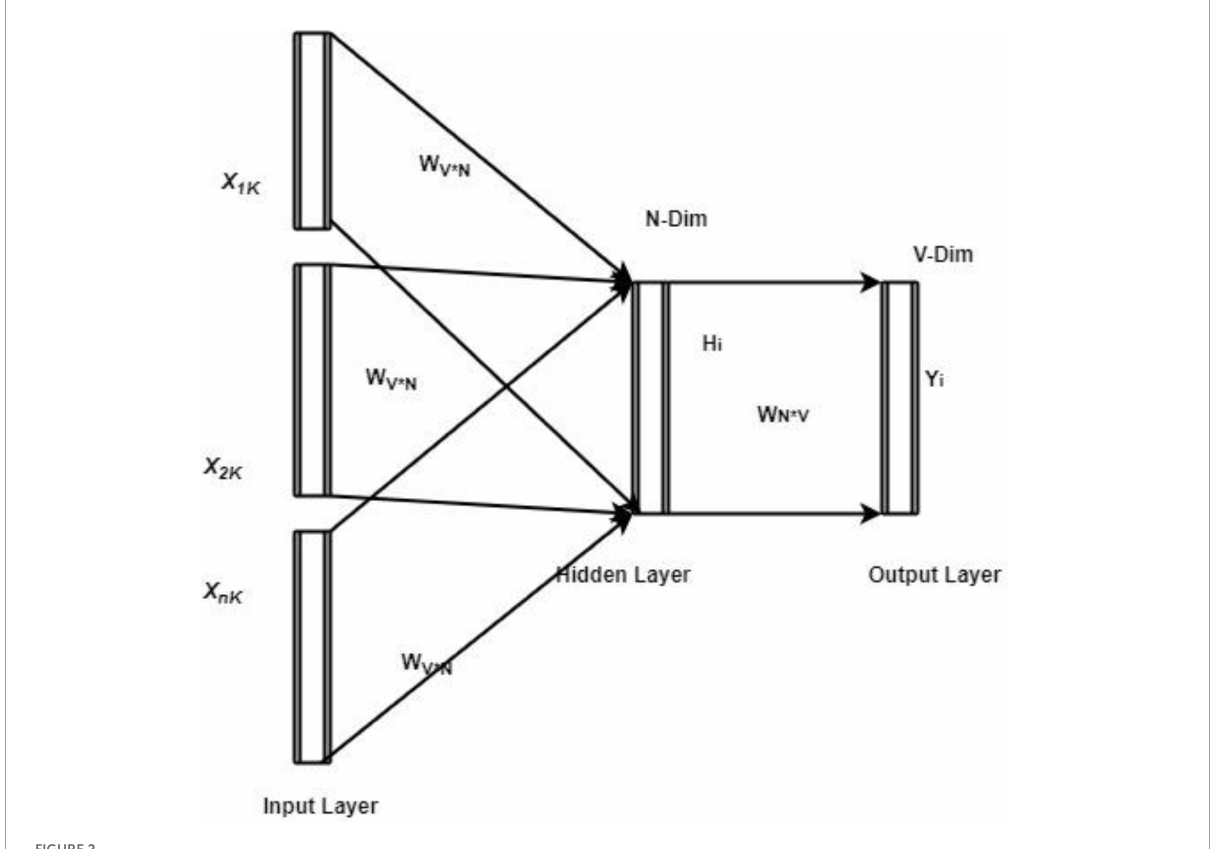
FIGURE2 CBOW-neural model